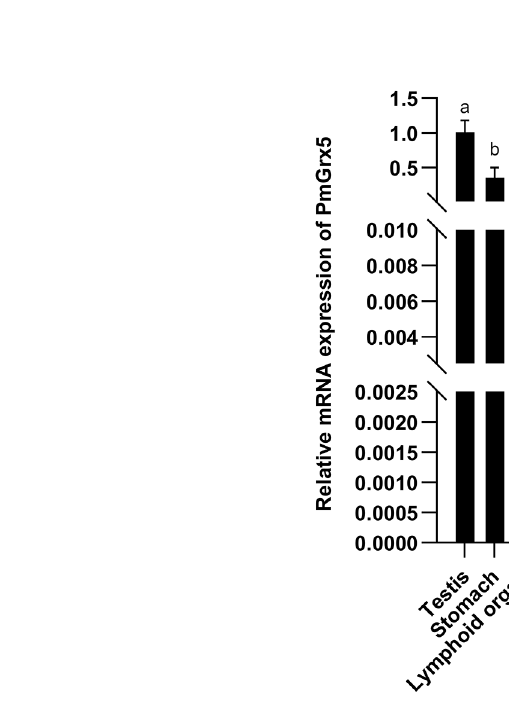
FIGURE 4 | mRNA expression levels of PmGrx5 in different tissues. The data are presented as mean ± SD ( n = 3). Different letters denote signi fi cant differences ( P < 0.05).